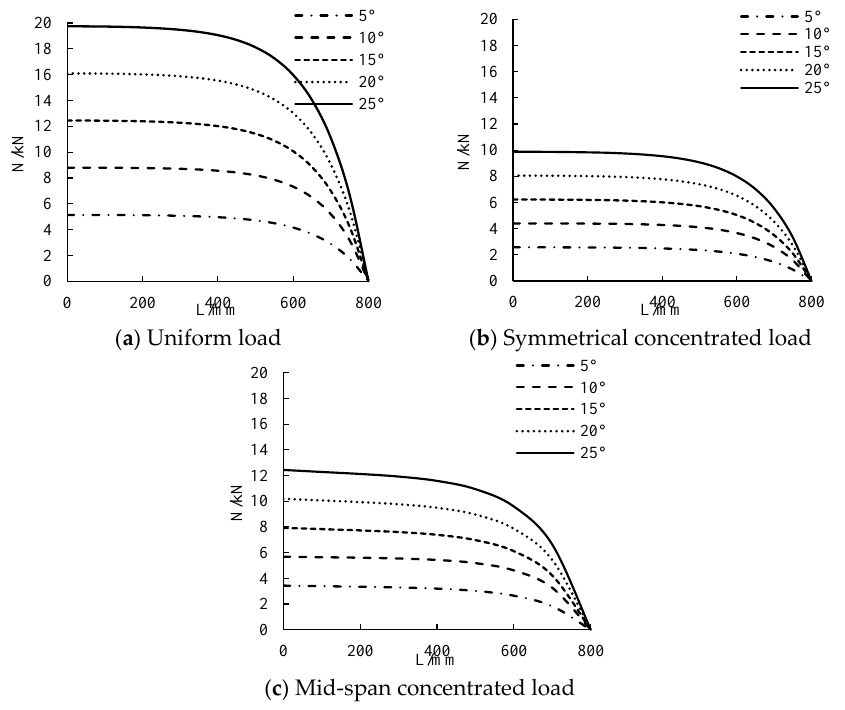
Figure 9. The influence of temperature on tensile force.